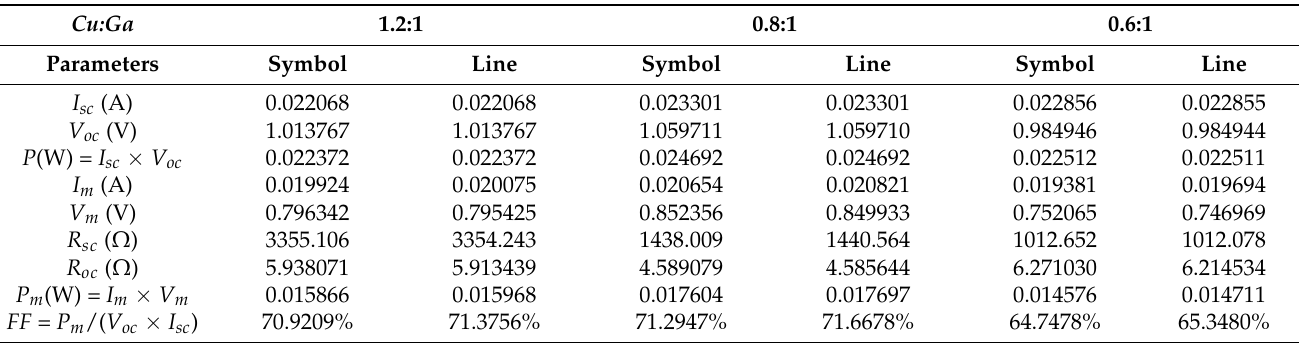
Table 4. Relevant factors acquired by extracted parameters calculation and experimental curve fitting in I- and P-V